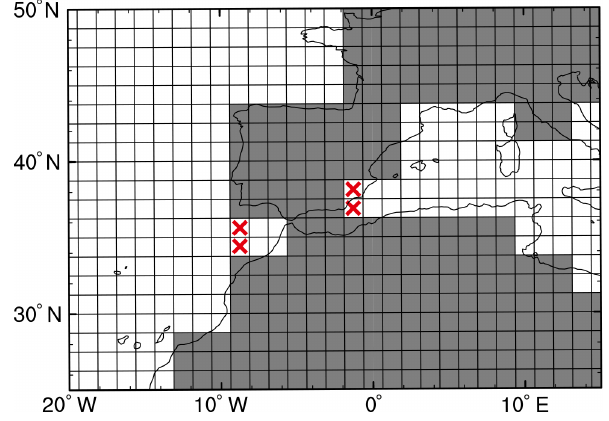
Fig. 3. HadCM3 land–sea mask in the Gibraltar straits region, with the model’s ocean grid and modern coastline overlain. Land is in grey, ocean in white. The four red crosses mark the grid boxes either side of the European–African land bridge that are connected by the “pipe” parameterisation of Mediterranean–Atlantic water exchange (see text in Sect.